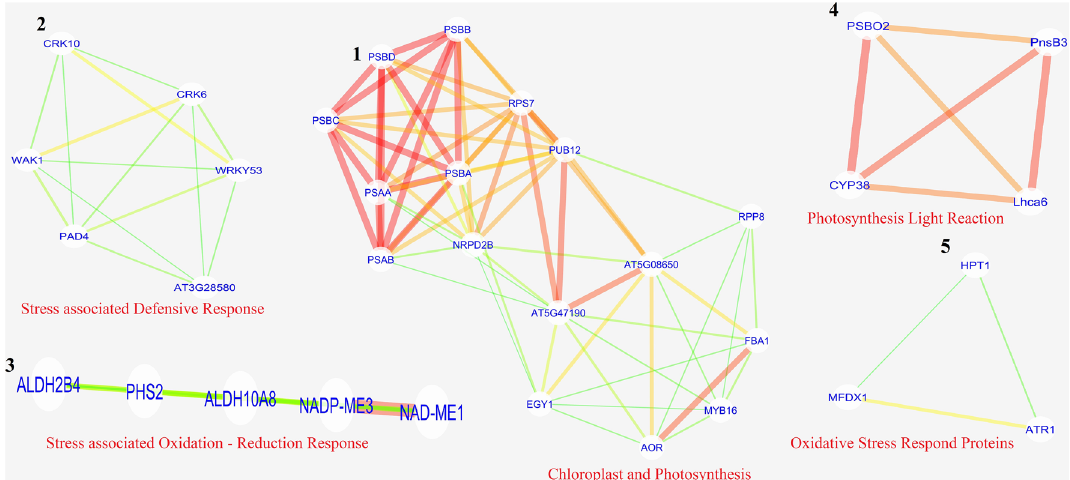
Figure 14. Functional sub-networking of highly interconnected nodes (up-regulated genes) using MCODE (version 2.0.0). Networks were built considering node density and node score cut-off value of 0.1, 0.2 respectively, with kappa-core value of